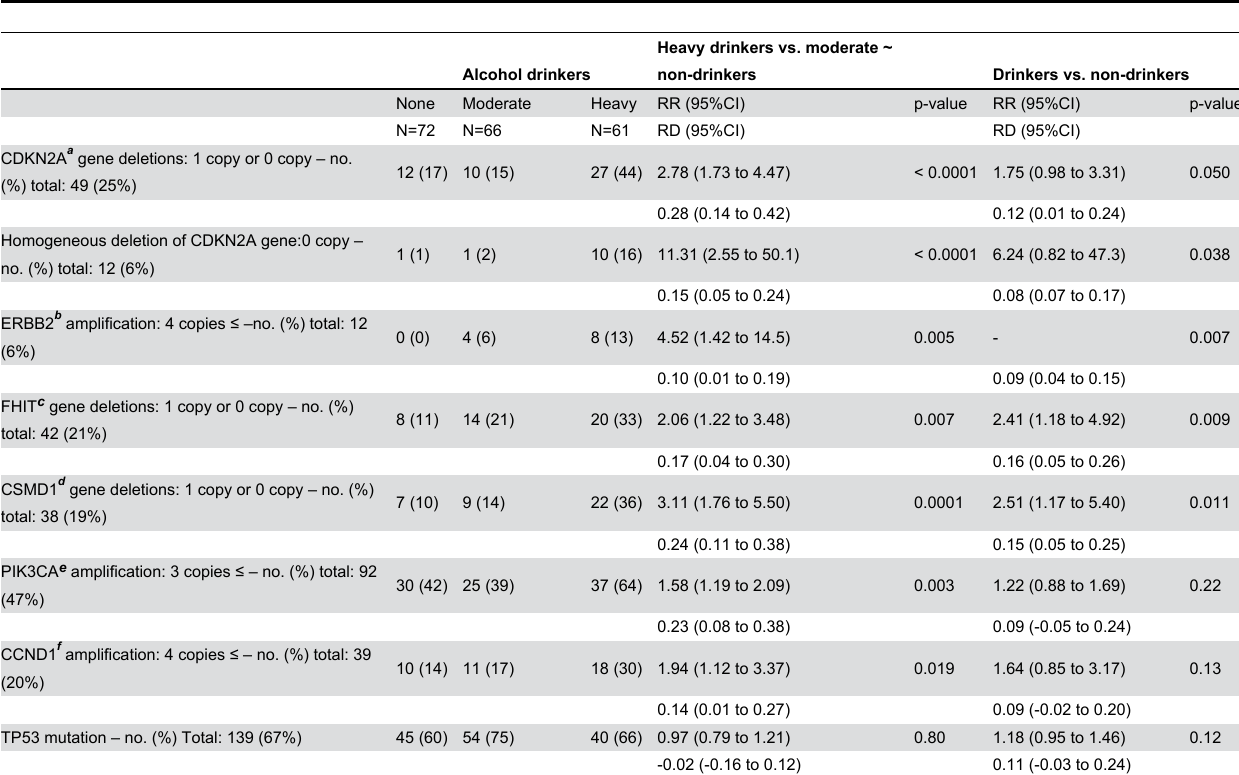
Table 2. Effects of alcohol drinking on SCNAs, TP53 mutations in HPV-negative patients.